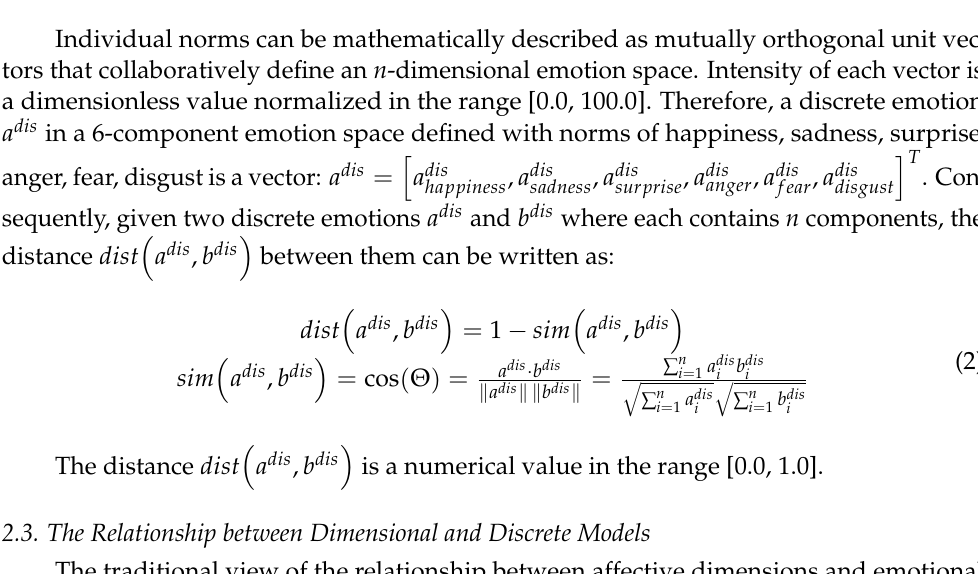
Figure 2. Examples of 6 discrete emotions represented in the NimStim picture database [34]. From top to bottom, and left to right: happiness, sadness, surprise, anger, fear, disgust. Adapted from [34].